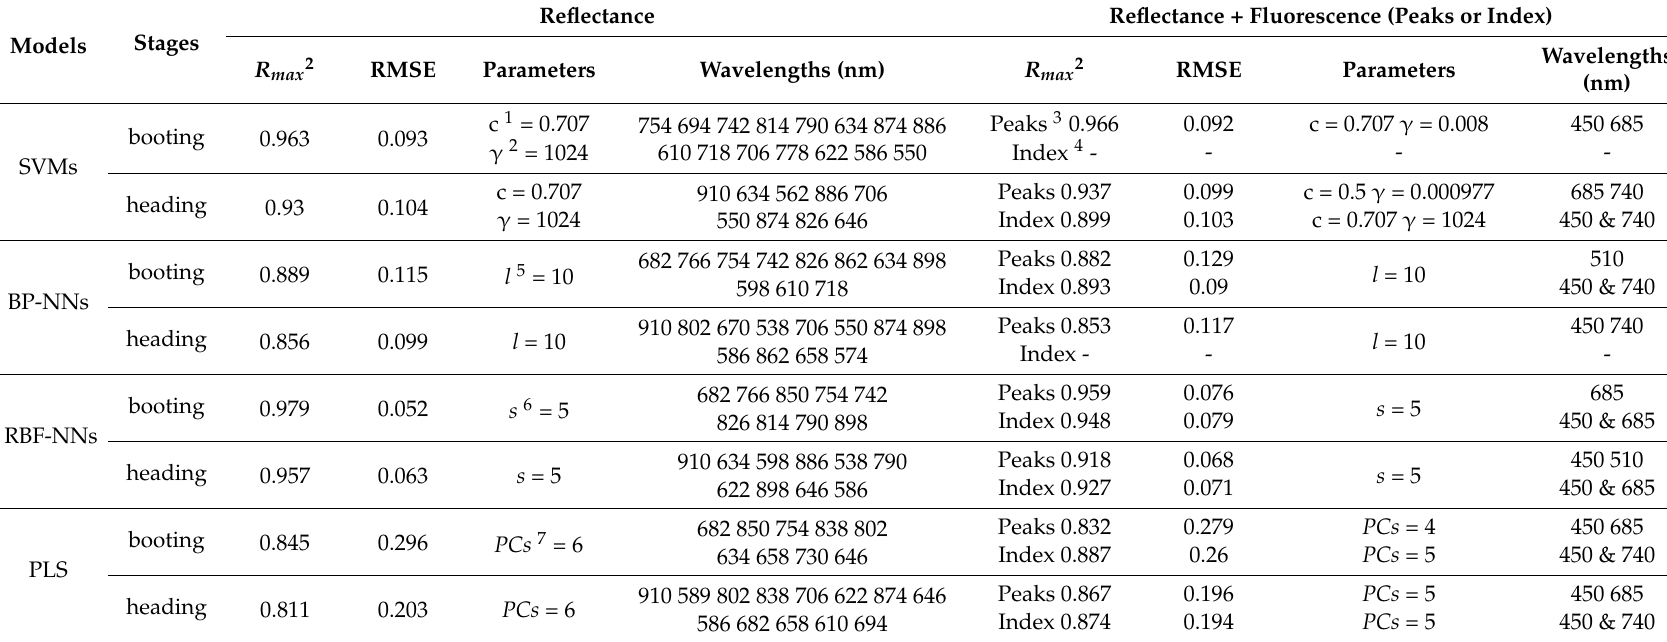
Table 1. The maximum R 2 and the wavelengths applied to LNC estimation with four regression algorithms in two growing stages of rice.